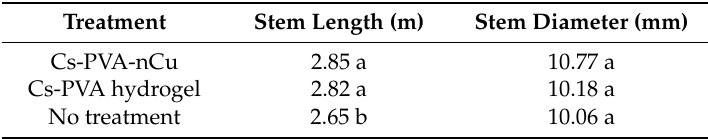
Table 2. Effect of Cs hydrogel treatments on selected watermelon growth variables.